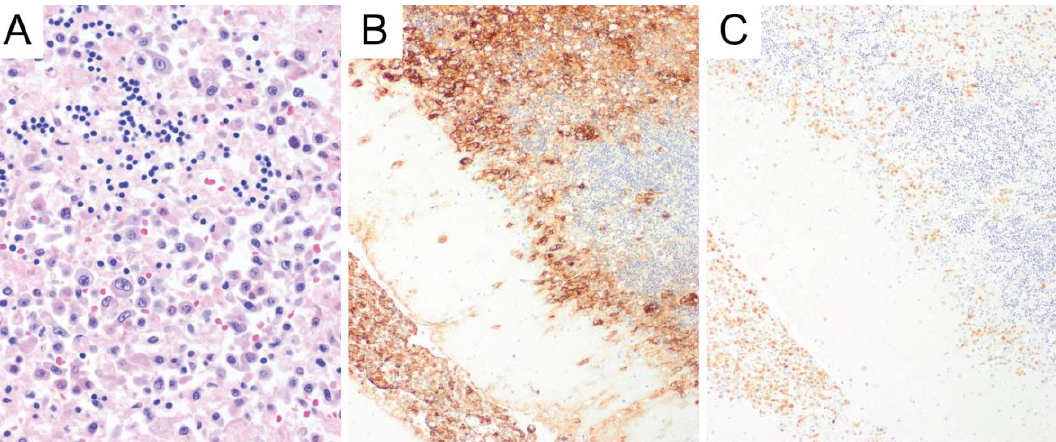
Figure 1. HIV-associated central nervous system lymphoma involving the cerebellum. The tumor cells are large with prominent nucleoli and abundant cytoplasm and are infiltrating between the native Purkinje neurons and internal granular cell layer of the cerebellum ( A . Hematoxylin and eosin/H&E, original magnification ×400). The tumor cells are positive for both CD20 ( B , original magnification ×100) and Epstein-Barr virus (EBV) by in situ hybridization ( C , original magnification ×100).